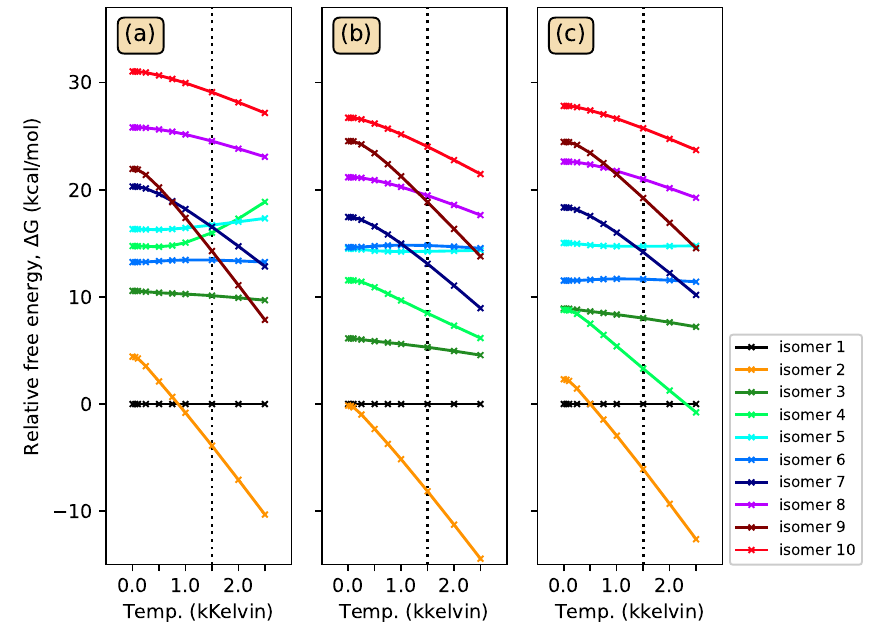
Figure 2. Relative free energies of the ten isomers in Figure 1 computed using the ( a ) MBPT(2), ( b ) B3LYP, and ( c ) M06-2X methods. The flash pyrolysis temperature reported in Ref. [2] is marked with a vertical dotted